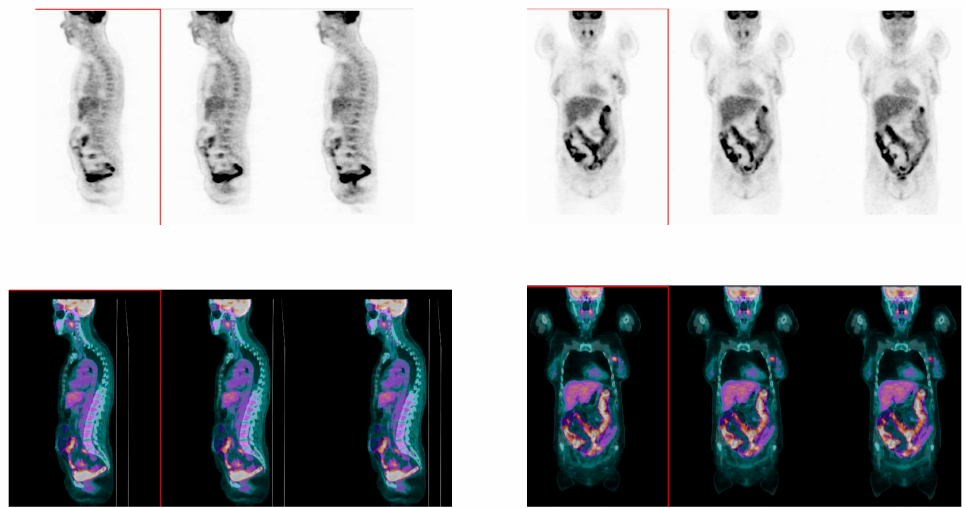
Figure 3. Sagittal (left panel) and coronal (right panel) images of whole-body [18]F-FDG PET/CT scan. PET (upper panels) and fused PET/CT (lower panels) images, showing diffuse nonhomogeneous [18]F-FDG uptake in colon and rectum in a BC patient who did not reach pCR.